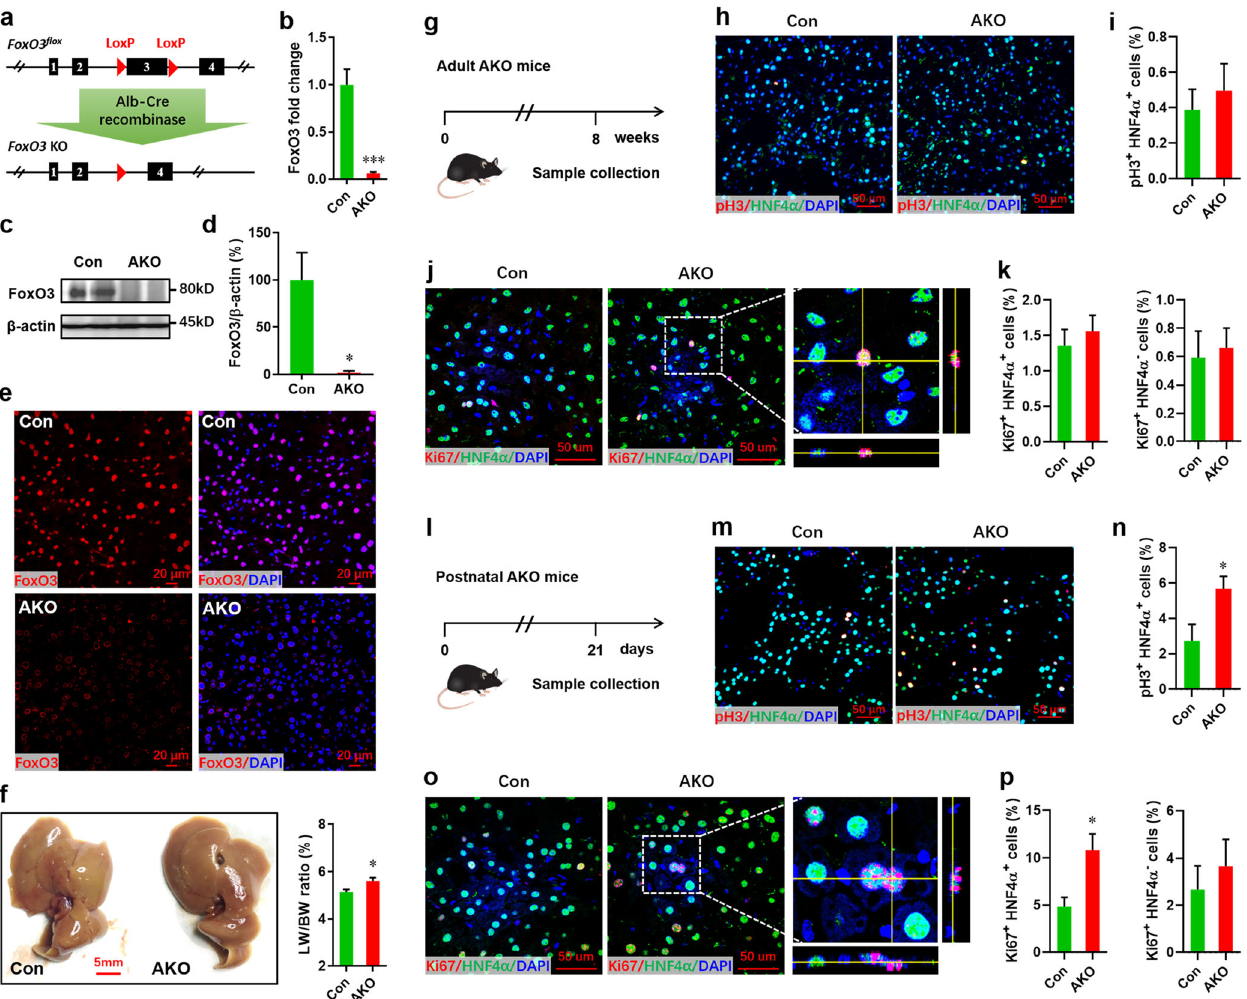
Fig. 2 Effects of the constitutive loss of FoxO3 on proliferation of hepatocytes. a FoxO3 fl / fl mice were crossed with mice Alb-Cre mice to generate AKO mice with constitutive deletion of FoxO3 in hepatocytes. b qPCR validation of FoxO3 expression in livers in adult mice at 8 weeks of age ( n = 5 mice). c , d Representative western blot images ( c ) and quanti fi cation ( d ) of FoxO3 expression in livers. e FoxO3 knockout in protein levels con fi rmed by immuno fl uorescence staining. f Representative liver images (left) and quanti fi cation of liver/body weight ratio (right) in control and AKO mice at 8 weeks of age ( n = 7 ~ 8 mice). g Schematic of sample collection in adult mice at 8 weeks of age. h and i Representative images ( h ) and quanti fi cation ( i , pH3 + HNF4 α + cells versus HNF4 α + cells) of pH3-positive hepatocytes in adult mice ( n =